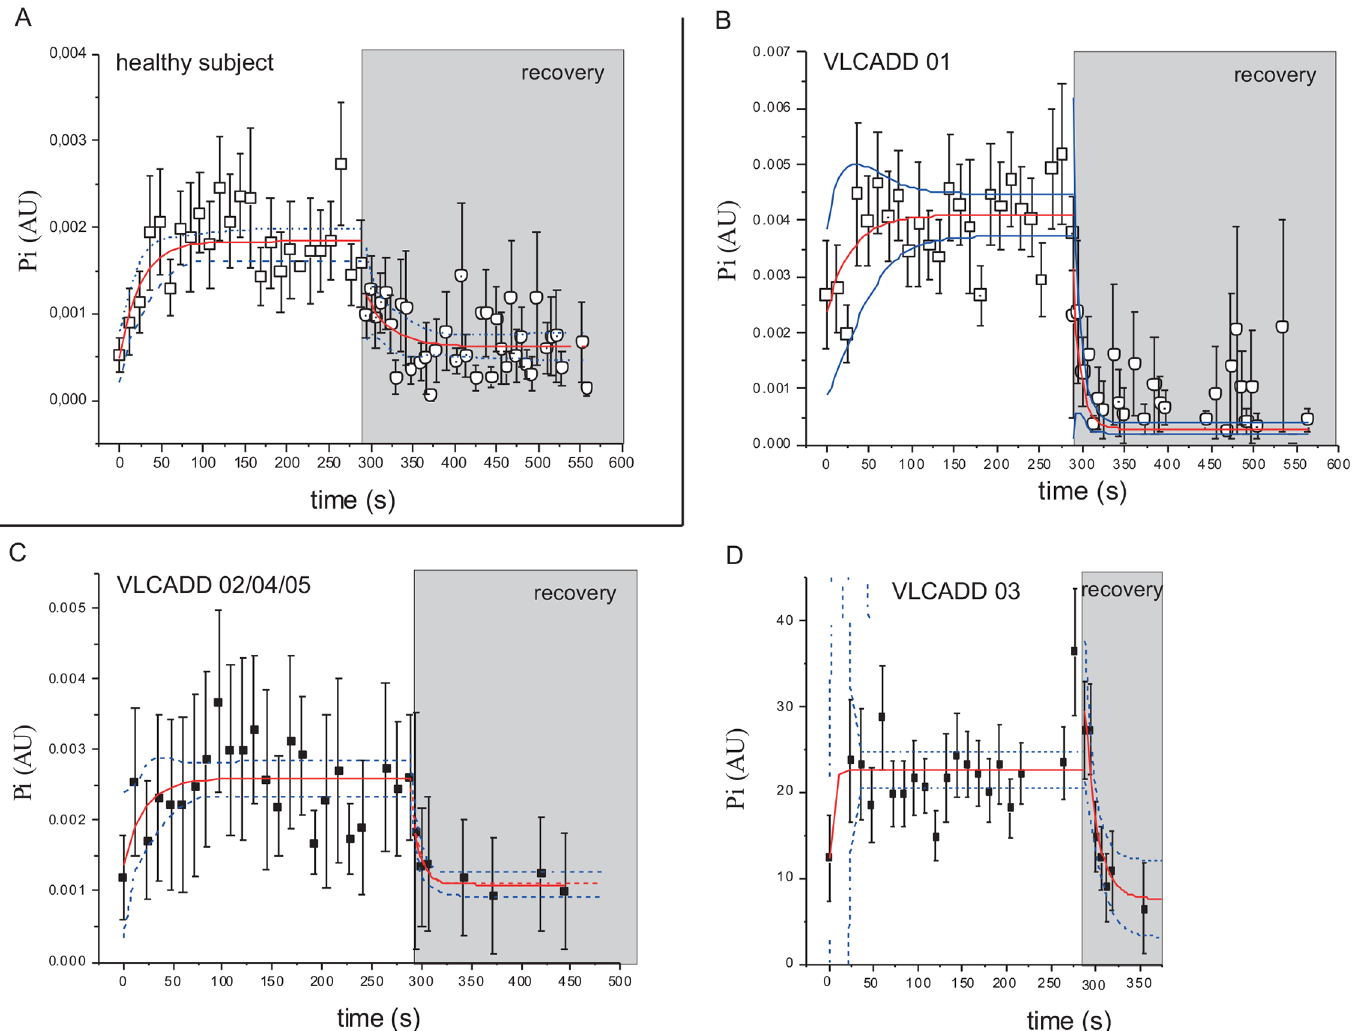
Fig 5. Pi dynamics during exercise and the first minutes of recovery rates. The error bars show the variance in the data from AMARES fitting of the MR spectra (see Methods section). (A) Healthy controls. (B-D) VLCADD patients. Solid red lines show the fit of a monoexponential function to the data; blue lines show the 95% confidence interval of the